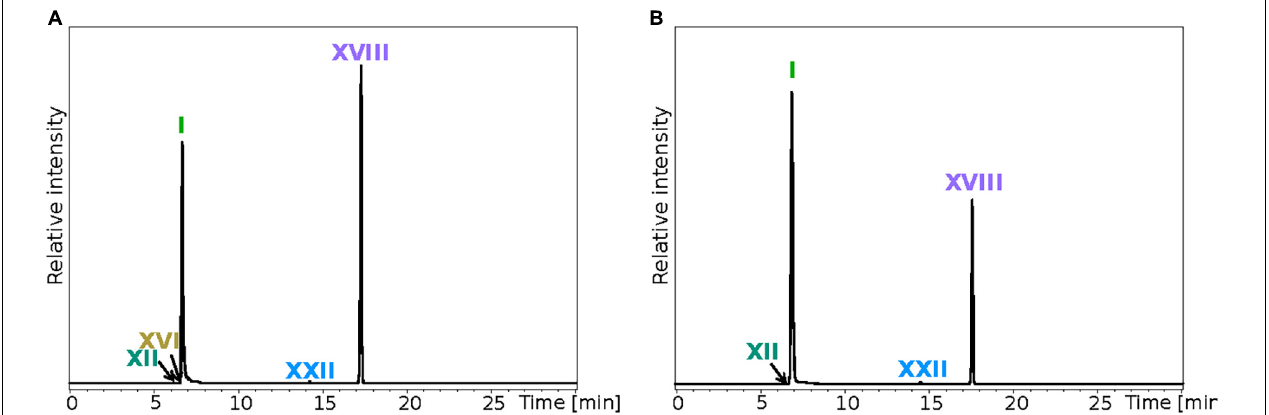
FIGURE 3 | Analysis of the core lipids (CLs) highlights a significant discrepancy between T. barophilus total and extracted lipids. Total CLs (A) and CLs from IPLs (B) were recovered after methanolysis of the biomass and the total lipid extract (TLE), respectively. Direct methanolysis and intact polar lipid extraction were both performed on the same amount of biomass. UHPLC chromatograms were drawn in positive mode by extracting the following protonated ions with a mass deviation of ± 0.1 Da: 653.68, 667.70, 723.76, 743.71, 1302.32, and 1304.34. Refer to Figure 1 for lipid structures.